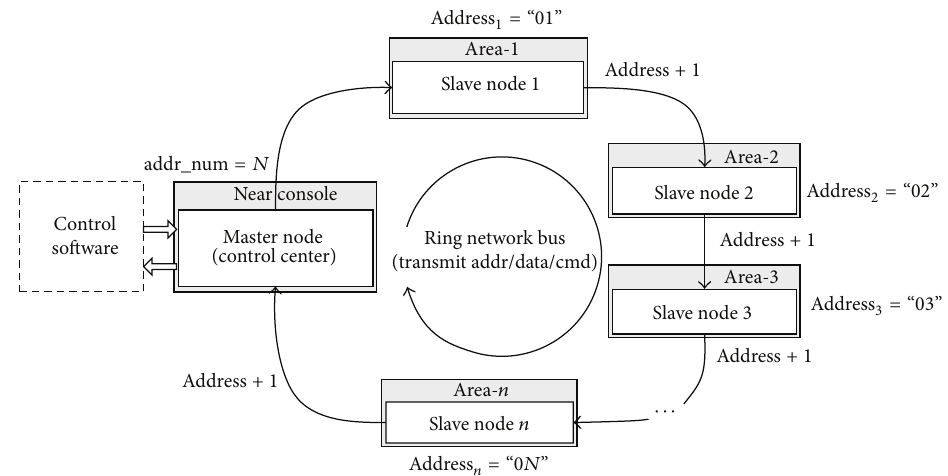
Figure 1: Structure of distributed multiparameter measurement